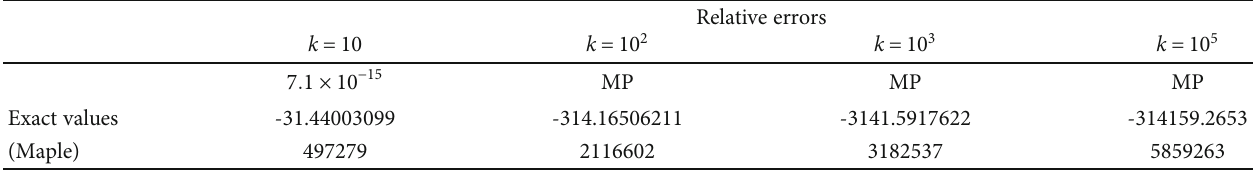
Table 1: Relative errors of the direct steepest descent method for .